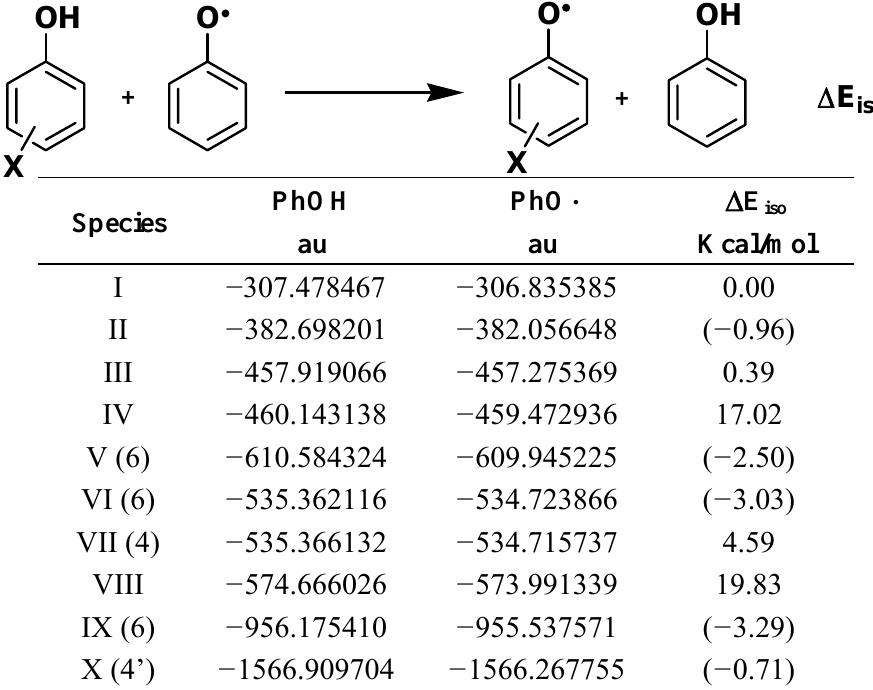
Table 1. Stabilization energy of the phenoxy radicals II – X relative to I. The position of the most stable fenoxy radical in given in